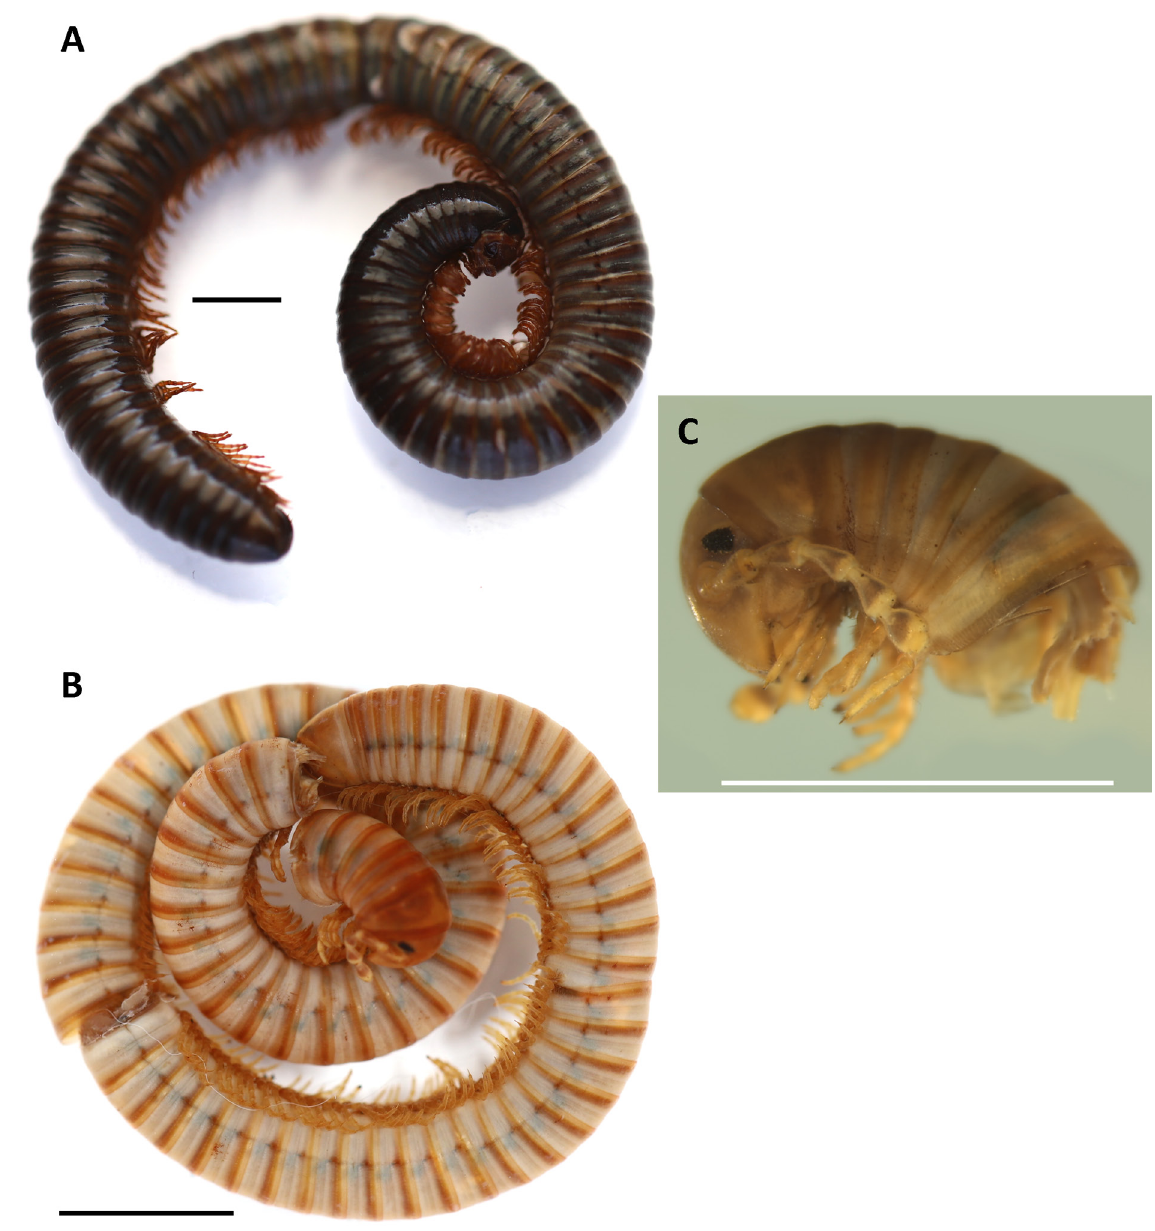
Fig. 3. Odontostreptus maroccanus (Attems, 1914) . A . ♀ from the Asni area (NHMD 52994). B–C . ♂, from 10 km before Ouzzane (NHMD 53001). Scale bars = 5